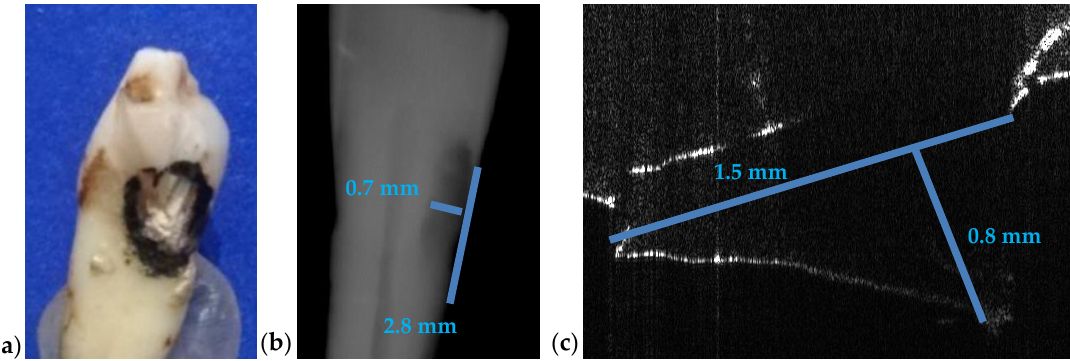
Figure 16. ( a ) Incisive tooth with an area marked for OCT investigations; ( b ) a section cropped from the intraoral radiography with measurements of the cavity; ( c ) OCT B-scan where the depth and the length measurements of the cavity have been performed.